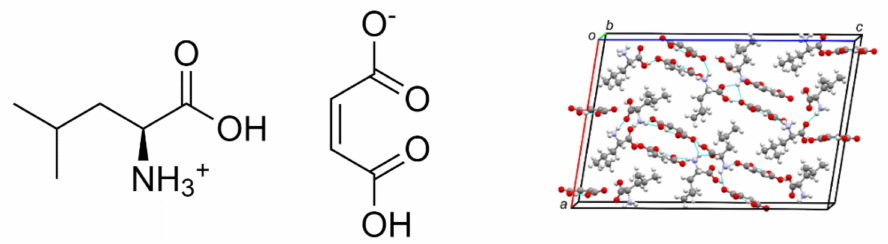
Figure 2. Molecular ( left ) and crystal structure fragment of LLHM at 298 K ( right ), showing 12 molecules of L-leucine and maleic acid each in the unit cell (CCDC# 1889564). Hydrogen bonds are shown by dashed lines.